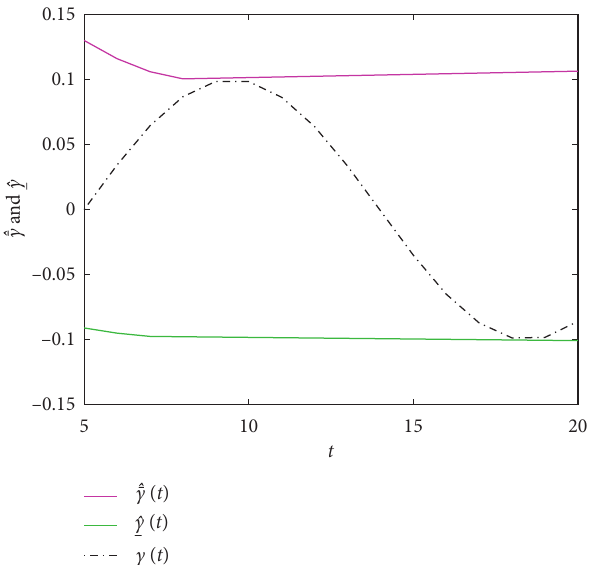
Figure 11: Actuator bias fault and estimations of its upper and lower